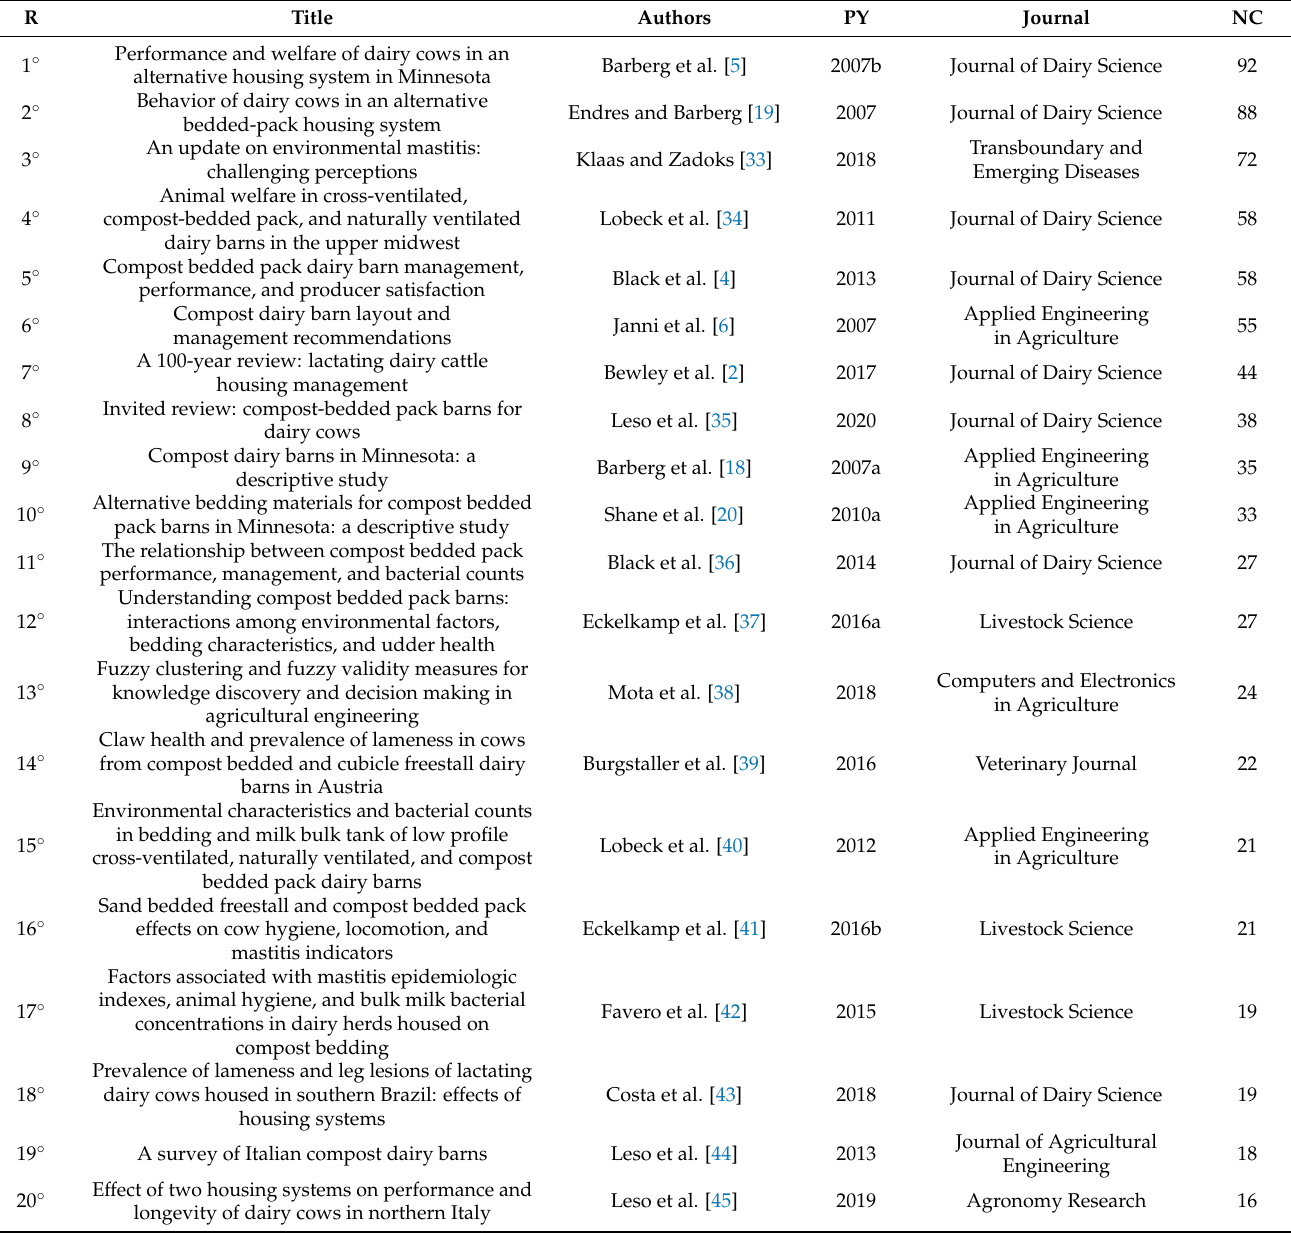
Table 1. Top 20 scientific publications on compost barn from 2007 to 2022/April, sorted by citation